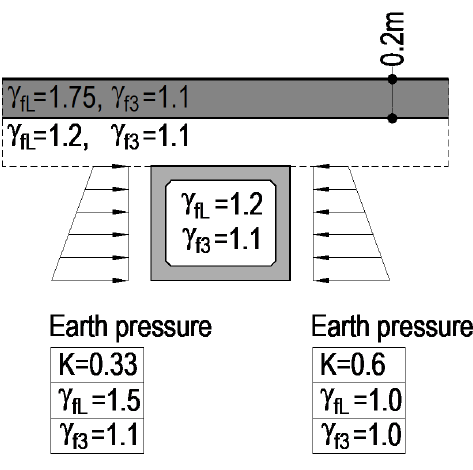
Figure 6: Partial load factors consistent with diagram A/4a [5]